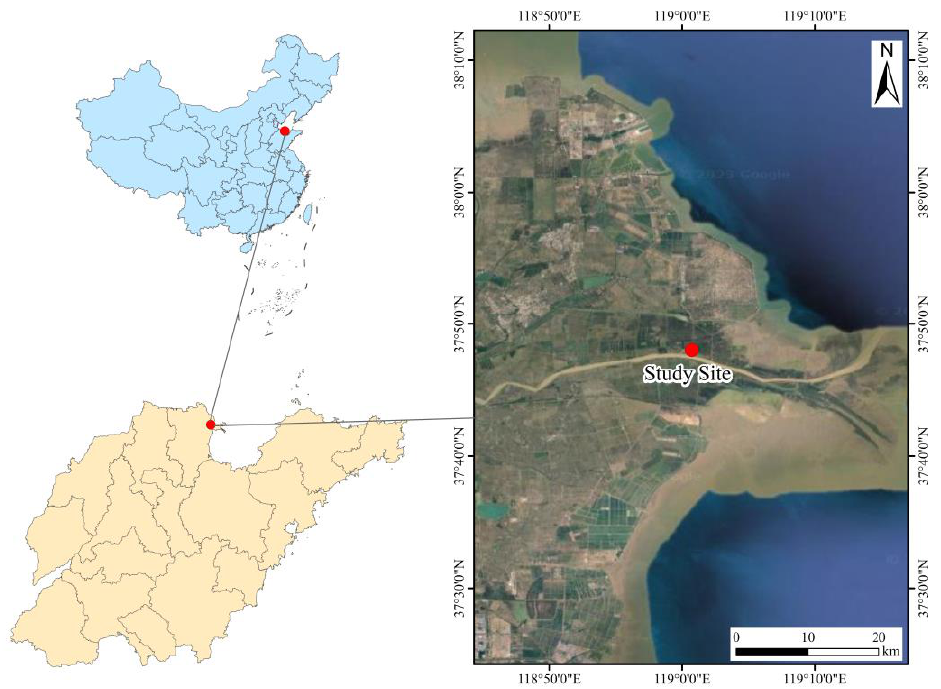
Figure 1. Experiment area.